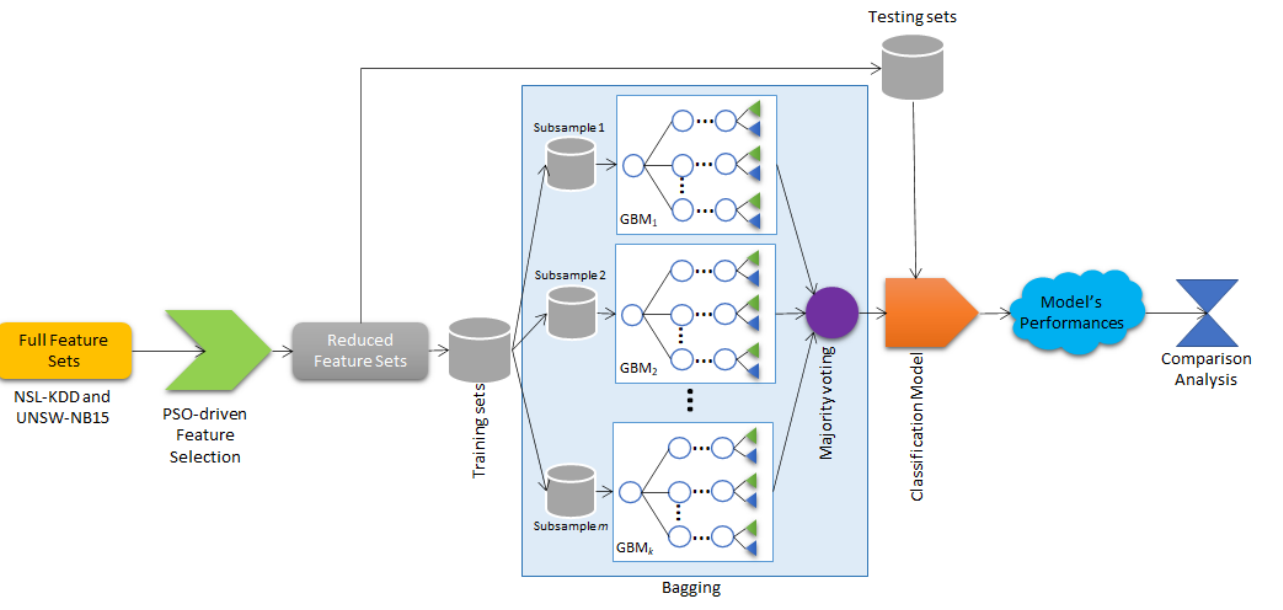
Figure 1. Proposed framework for intrusion detection based on PSO-driven feature selection and hybrid